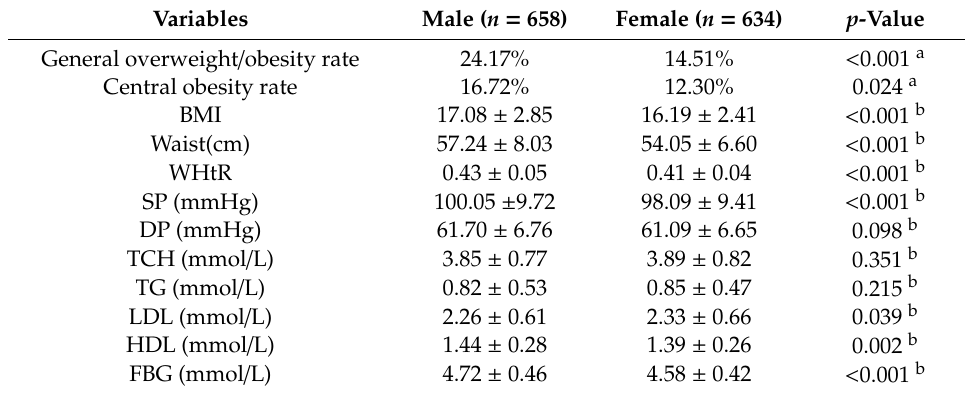
Table 2. Obesity-related variables compared by